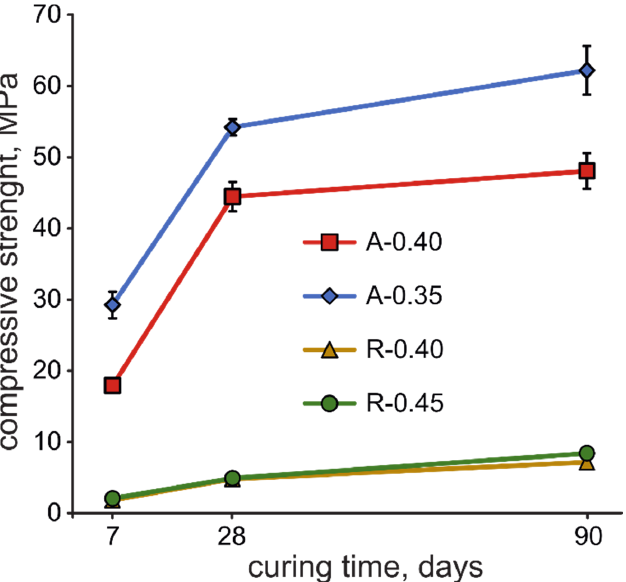
Figure 6. Compressive strength of raw fly ash pastes and the pastes made with ash grinded for 4 min, mixed at different water/ash ratios (0.35, 0.4, and 0.45) and cured for 7, 28, and 90 days. The mechanical activation shows a significant positive effect on compressive strength of the pastes already after 7 days of curing. The relative increase in compressive strength is more pronounced after 28 days. Further increase by 90 days of curing is less than 10% of the final strength.